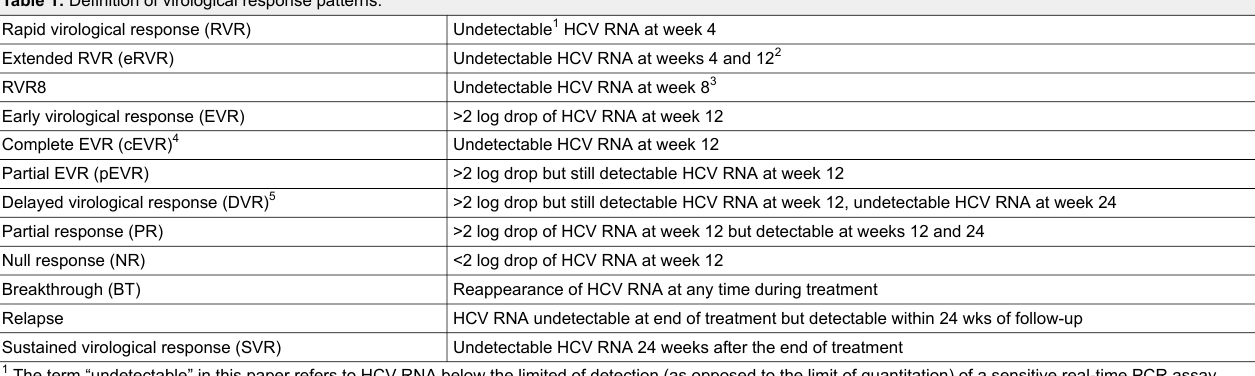
Table 1: Definition of virological response patterns. Rapid virological response